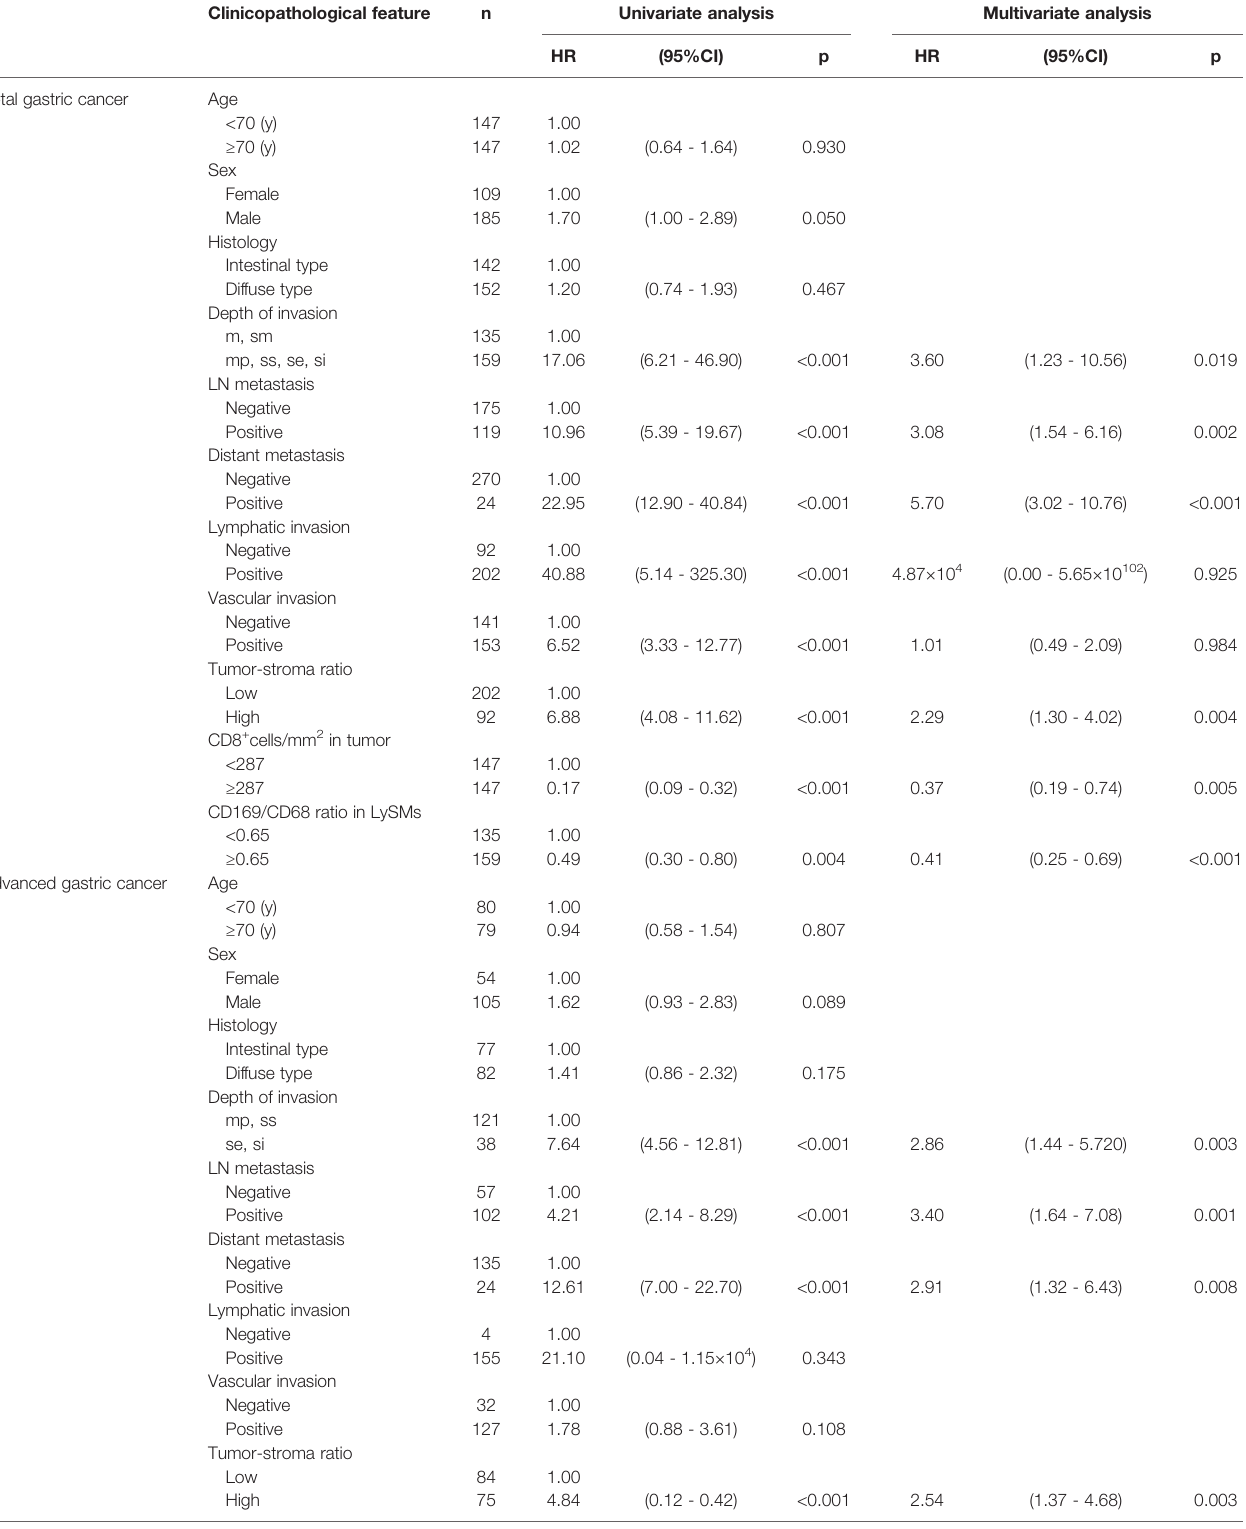
TABLE 2 | Univariate and multivariate Cox regression analysis of potential prognostic factors for cancer speci fi c survival in patients with total gastric cancer (n = 294) and advanced gastric cancer (n = 159). Clinicopathological feature n Univariate analysis Multivariate